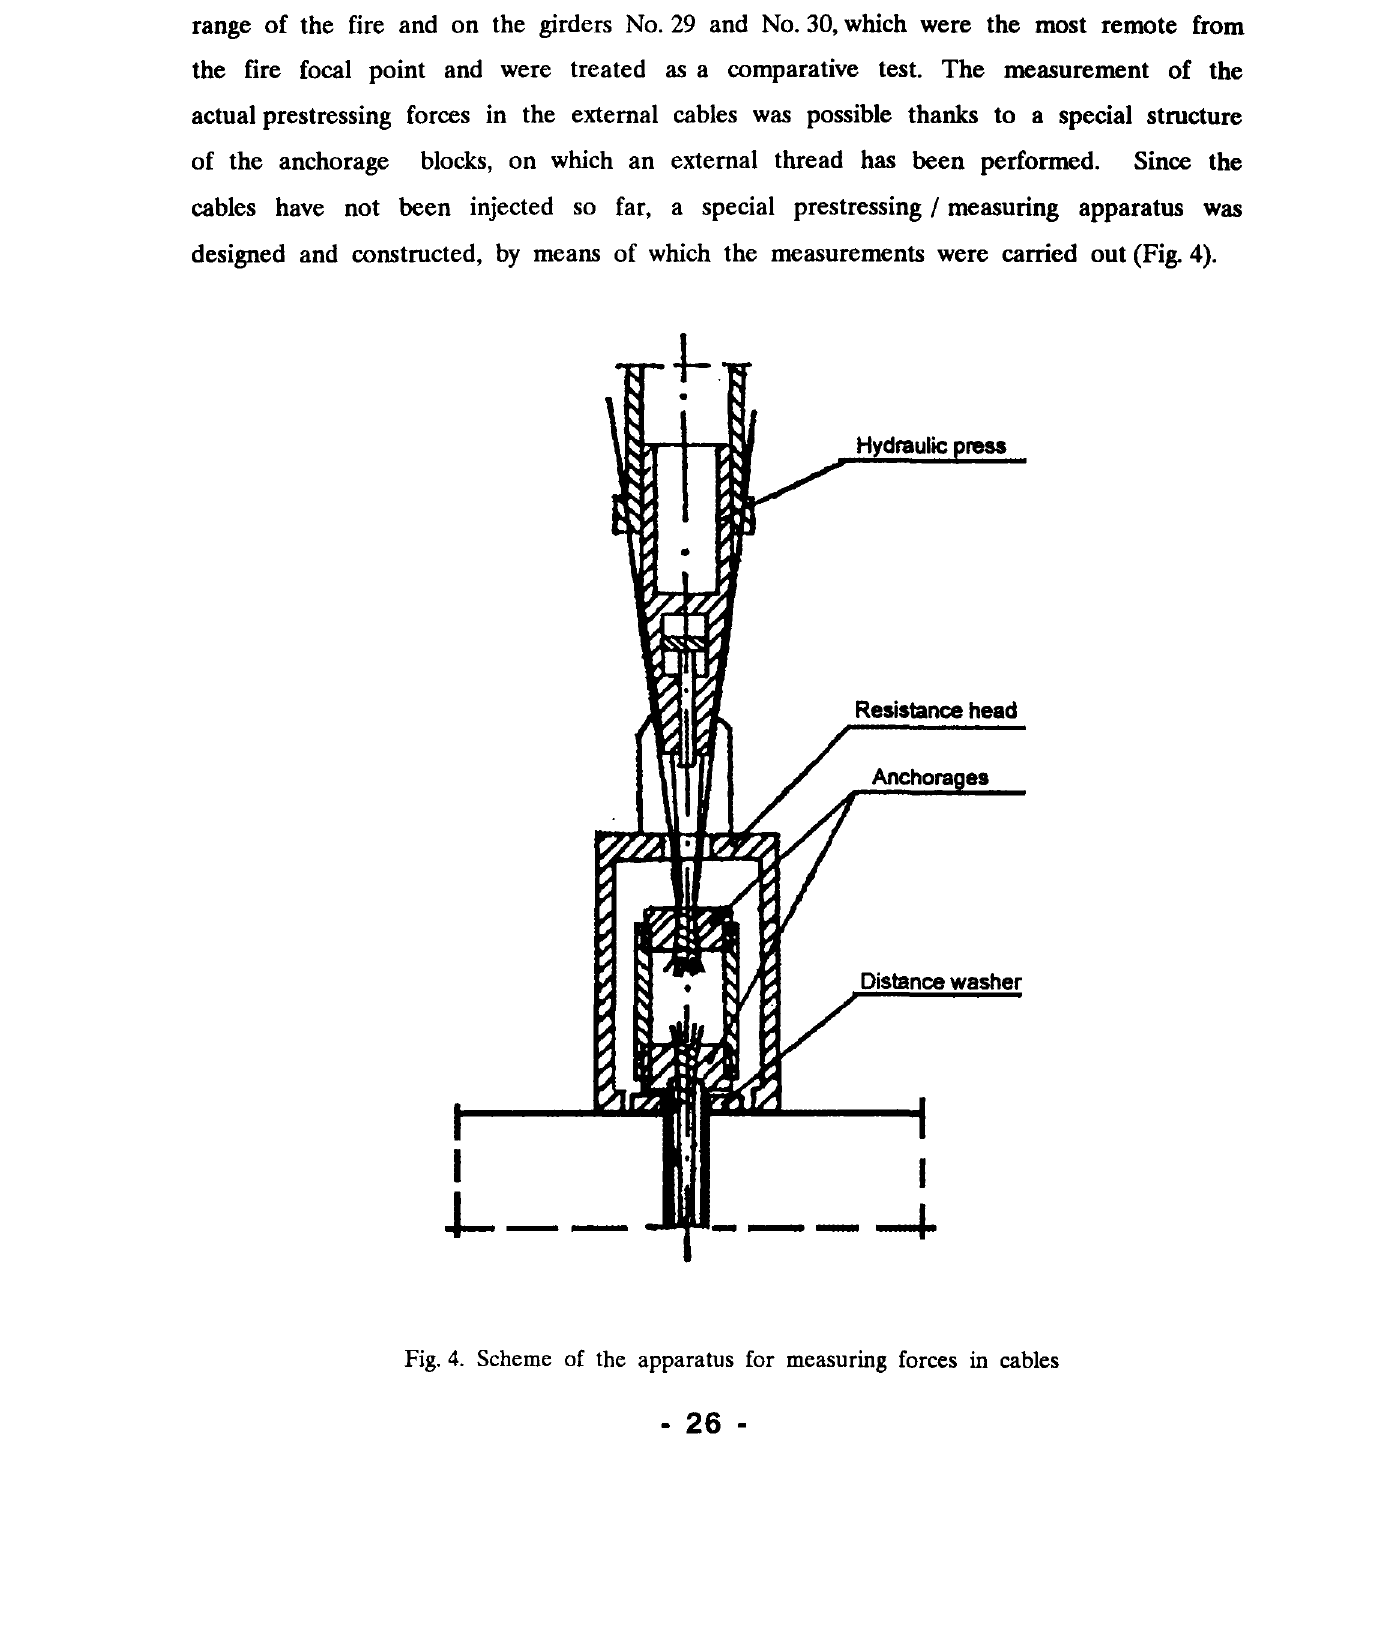
Fig. 4. Scheme of the apparatus for measuring forces in